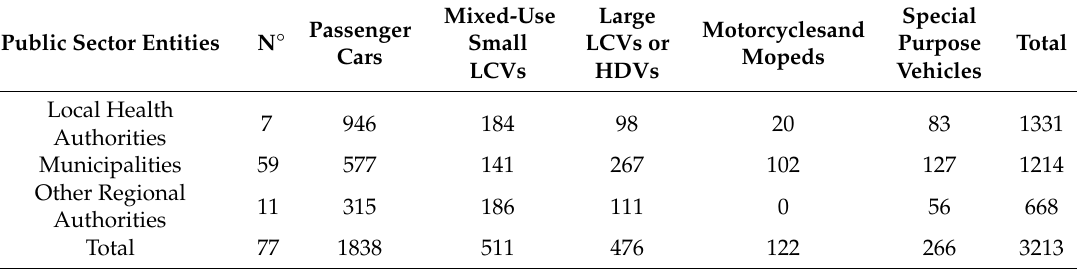
Table 2. Vehicles in the three public sector